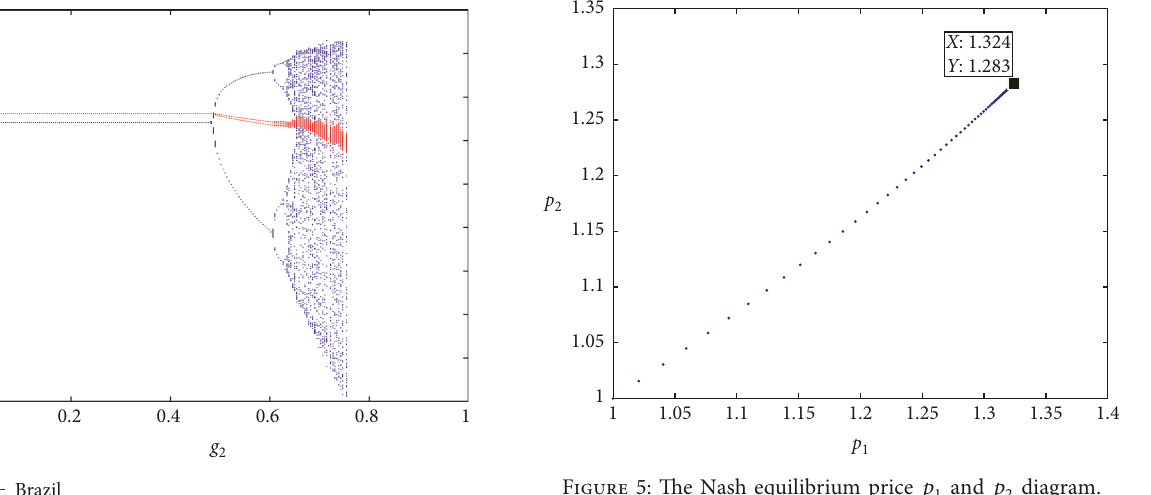
and p diagram. 1 2